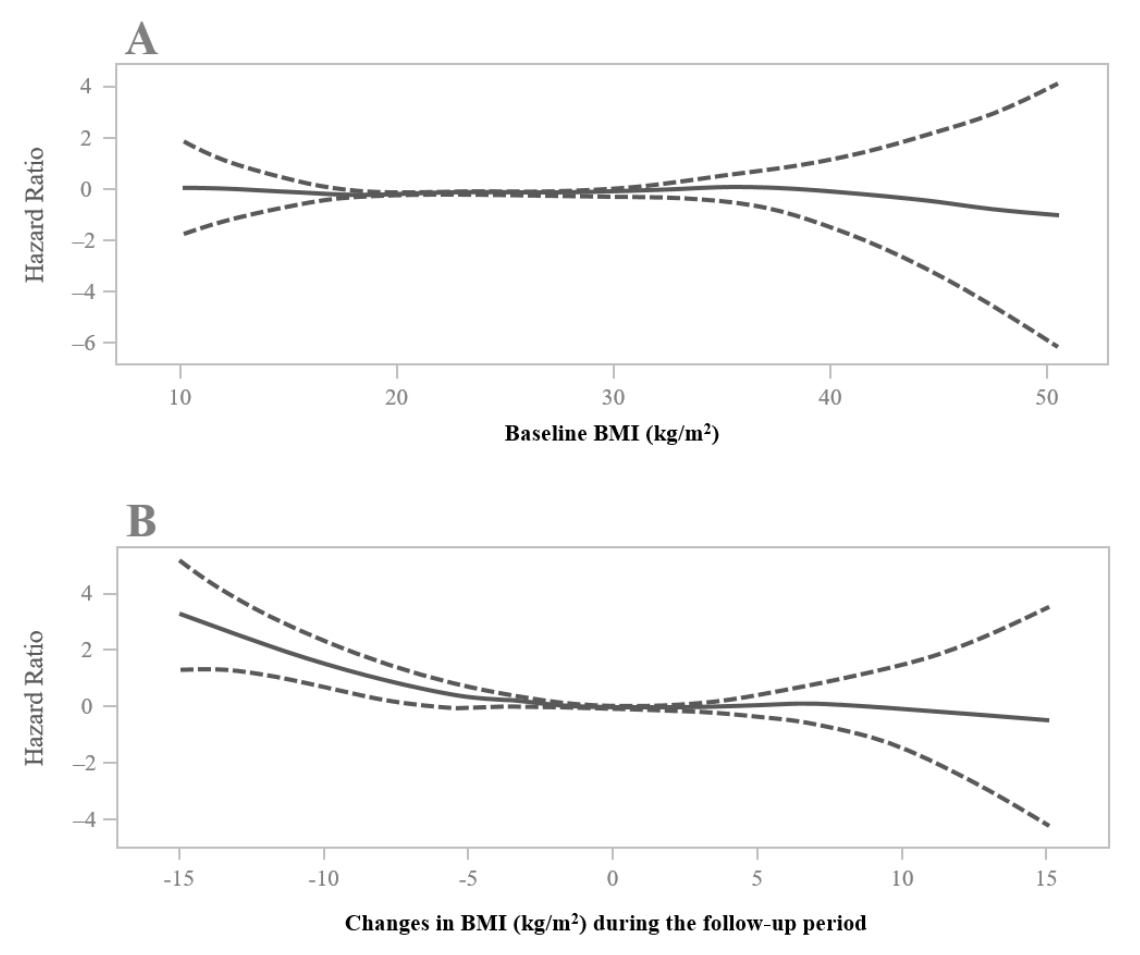
Figure 2. Cox proportional hazard spline curves showing associations between recurrent and persis- tent hematuria in glomerular disease and ( A ) baseline BMI (kg/m 2 ) and ( B ) changes in BMI (kg/m 2 ) during the follow-up period. BMI, body mass index.